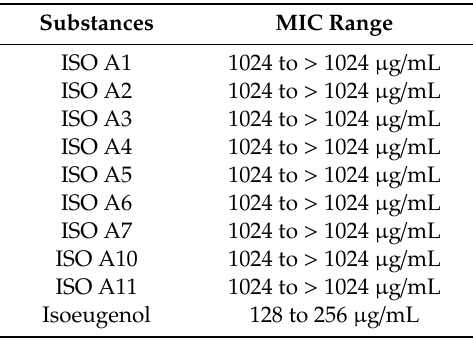
Table 1. Screening of hybrid acetamides and isoeugenol antifungal activities against Candida albicans strains (Minimum Inhibitory Concentrations—MICs).